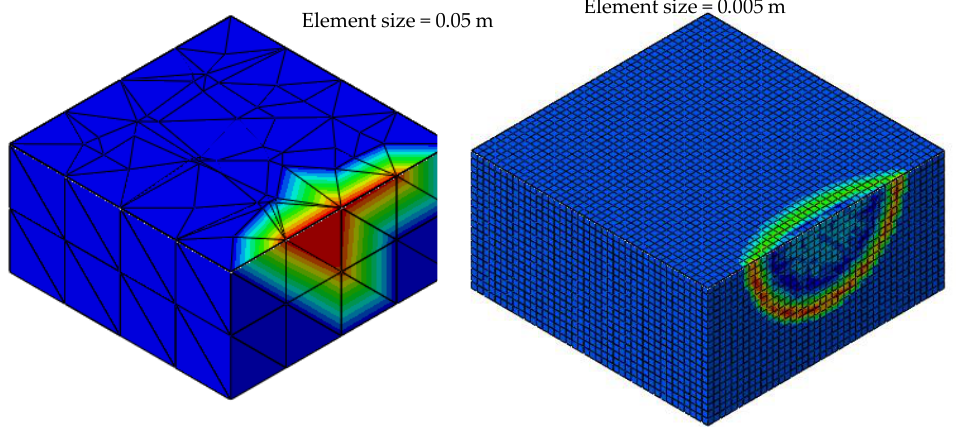
Figure 13. Spherical shock wave in different mesh elements at the same time step. On the left there is a visible blur of the shockwave character caused by insufficient mesh density.